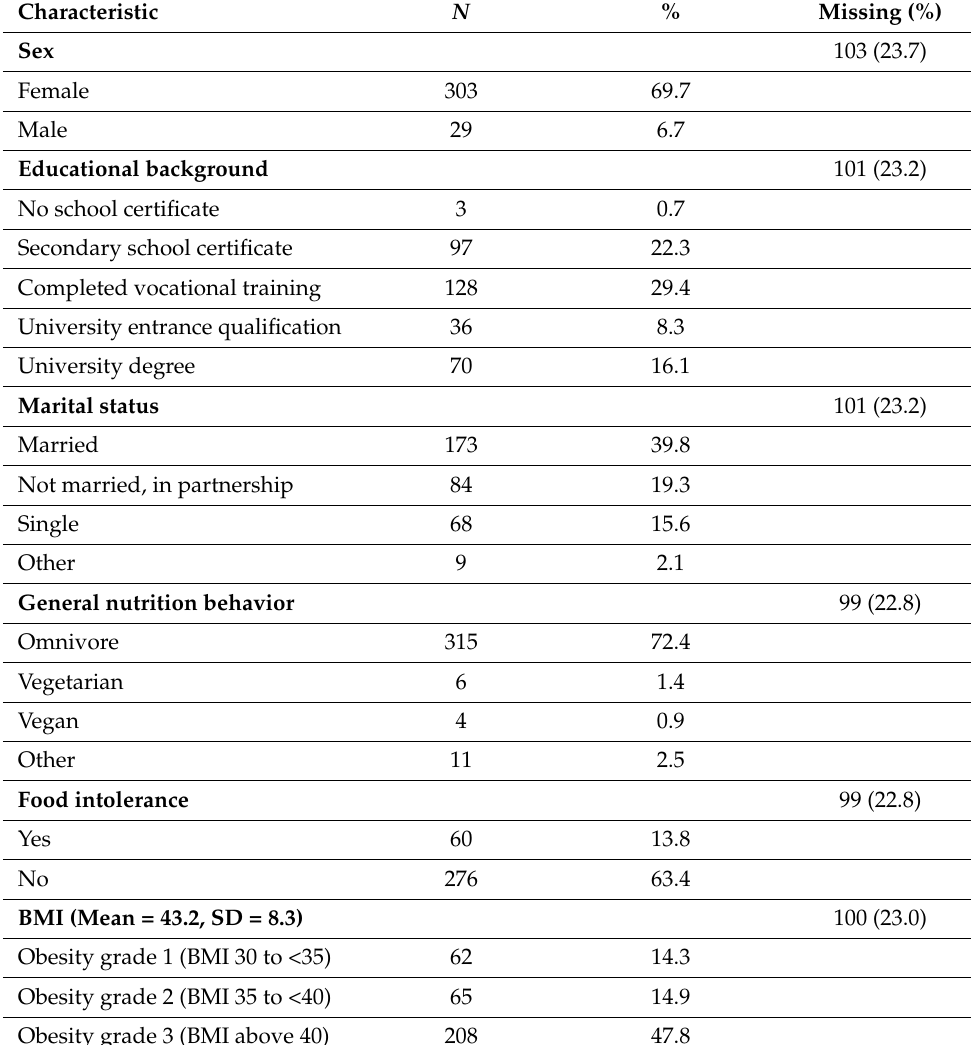
Table 1. Sociodemographic sample characteristics.